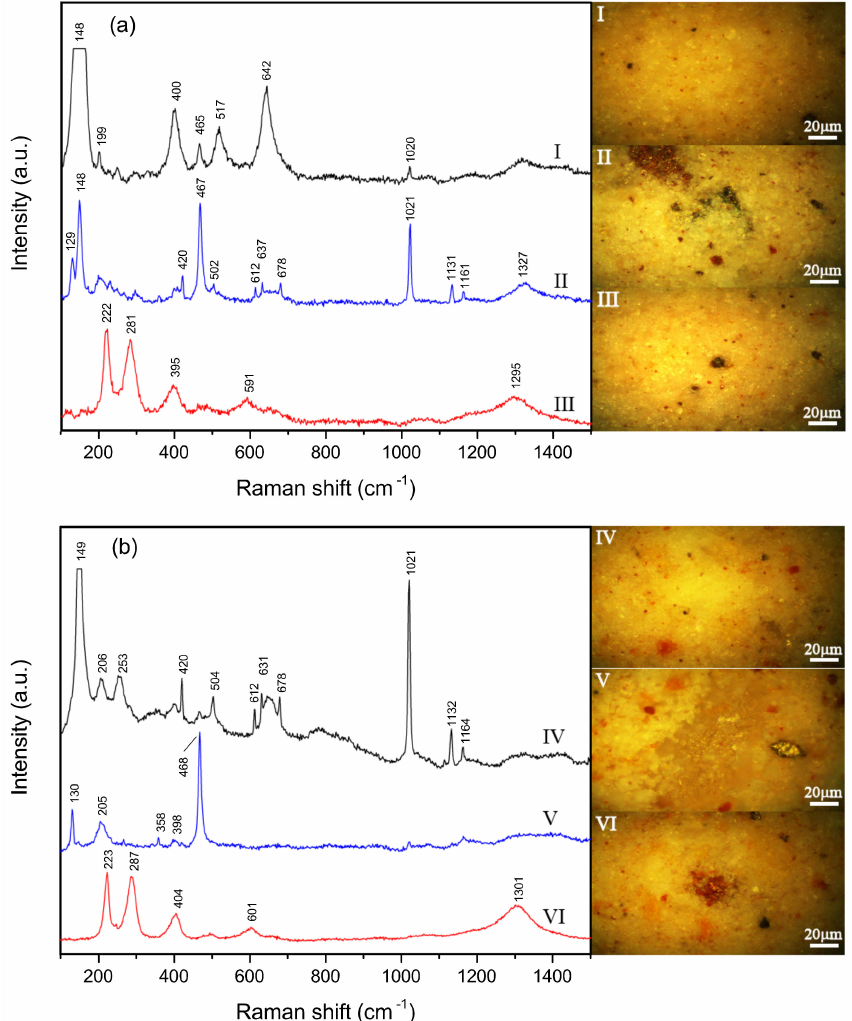
Figure 4. Typical Raman spectra and micrograph for coal ashes: ( a ) Coal ash A and ( b ) coal ash B. Typical components are: I—anatase, quartz, and anhydrite; II—quartz, anatase, and anhydrite; III—hematite; IV—anatase, quartz, and anhydrite; V—quartz; and